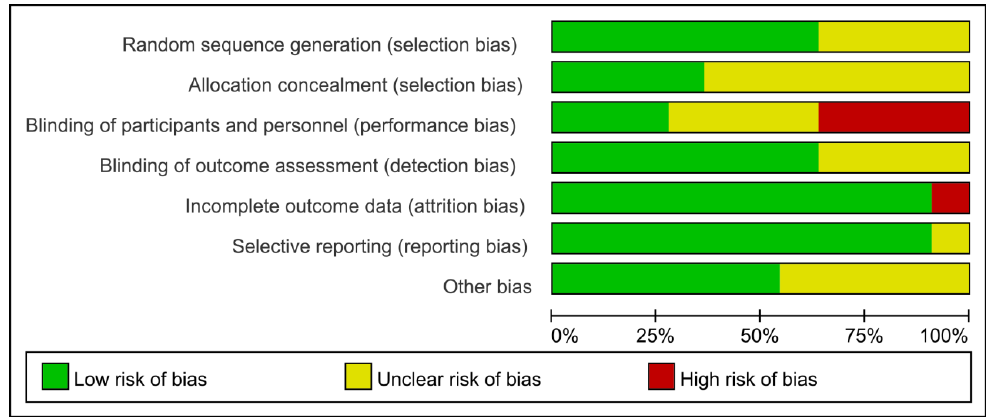
Figure 2. Risk of bias plot.